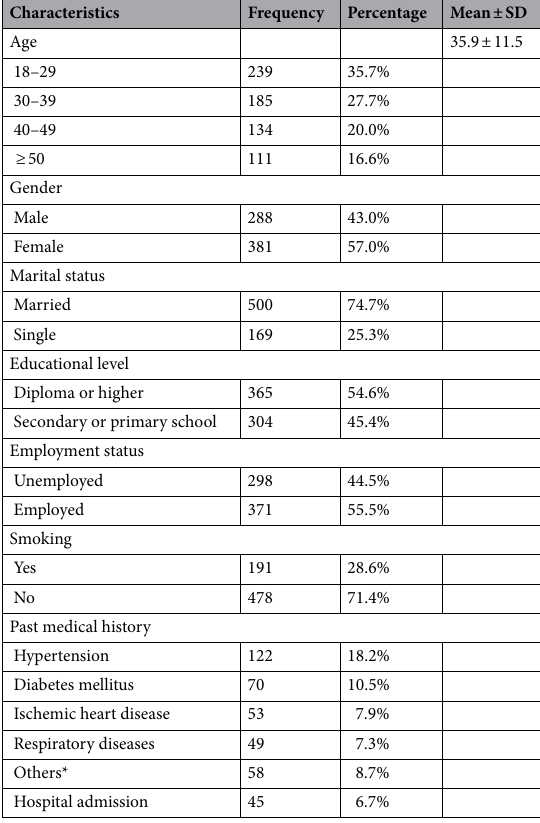
Table 1. Background and clinical characteristics of the participants (n = 669). *Hypo/hyperthyroidism, inflammatory bowel disease, breast cancer, hepatitis.